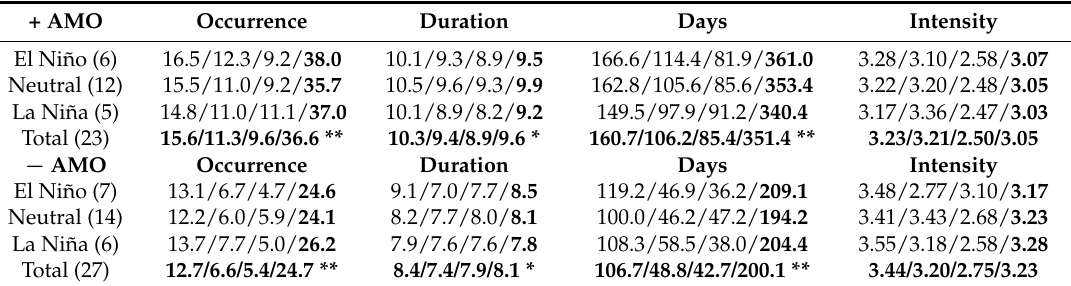
Table A3. As in Table A1, except as a function of ENSO and AMO.